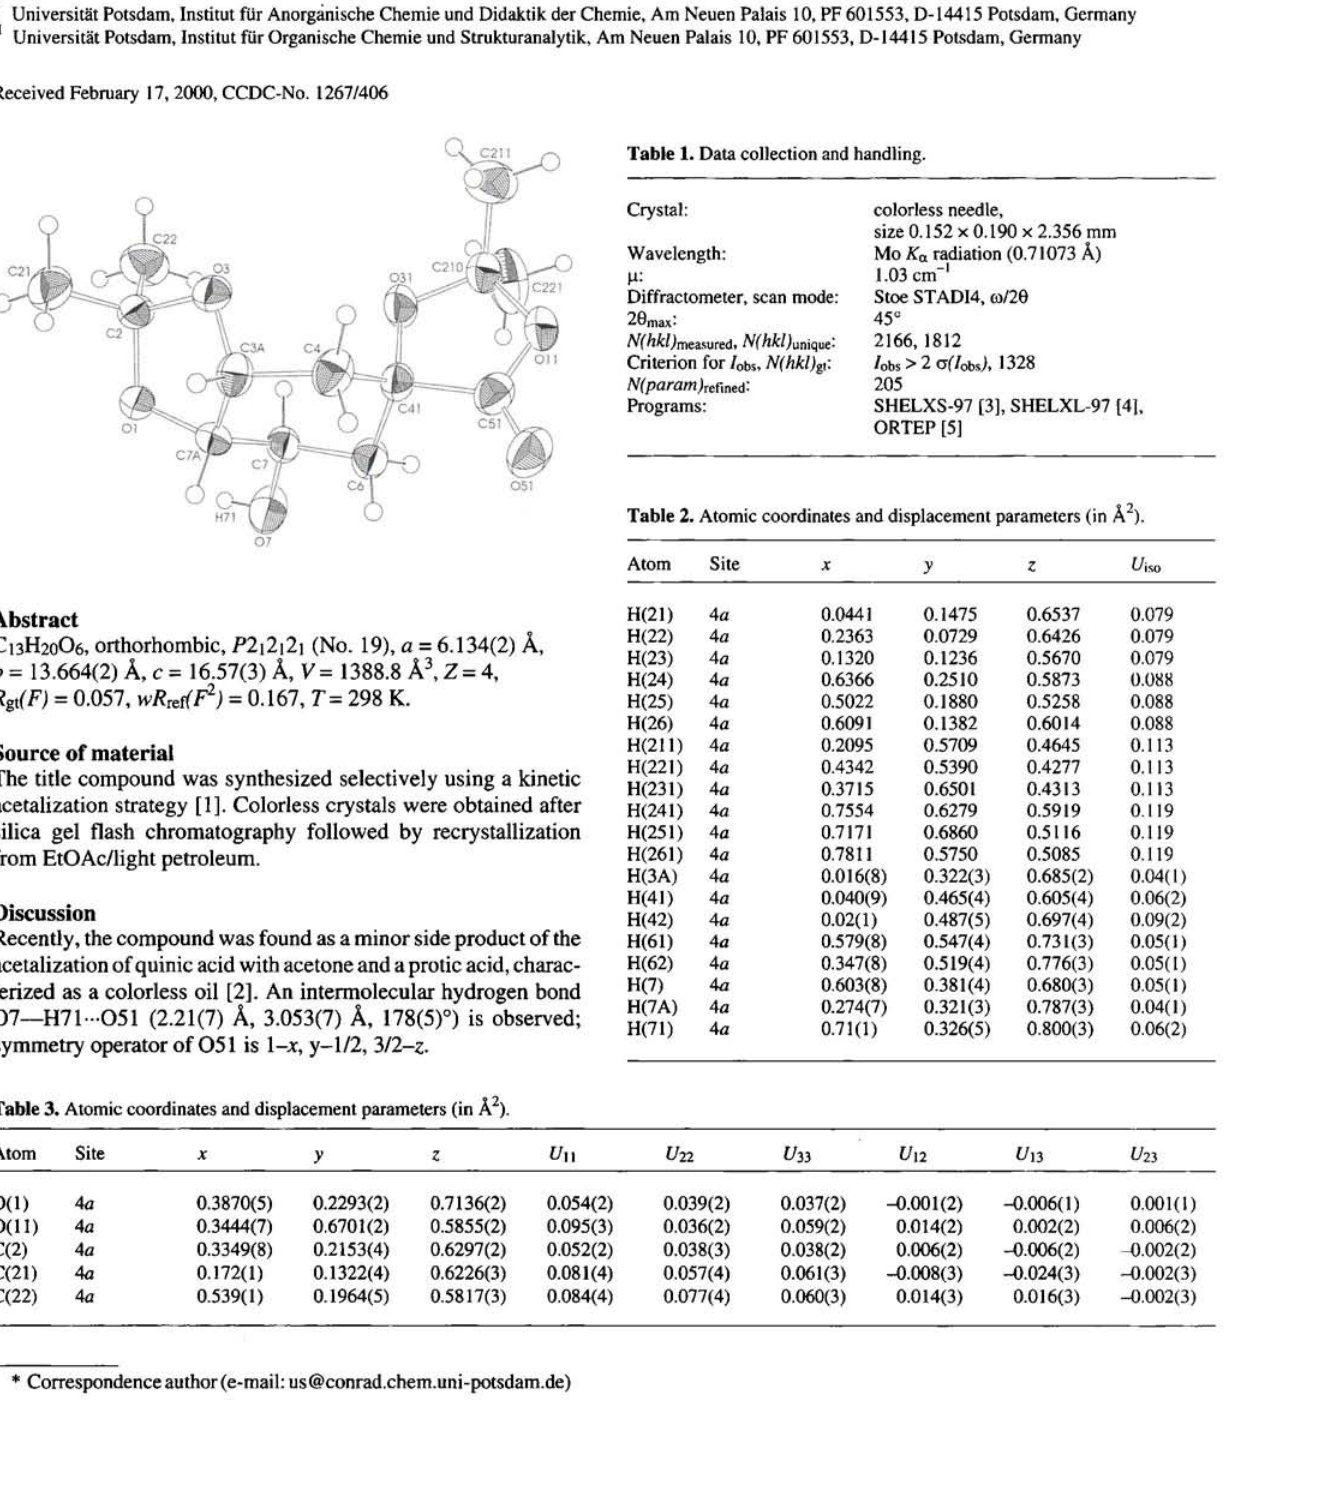
Table 1. Data collection and handling.